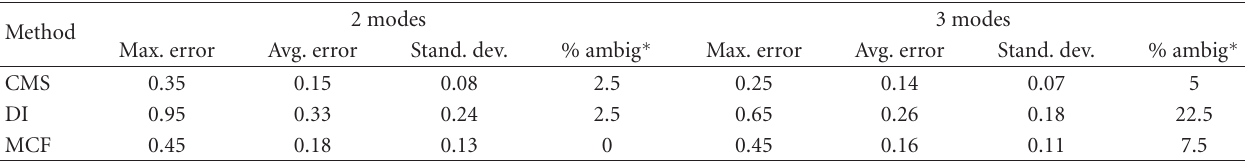
Table 4: Error in predicted damage location by each method, listed as a fraction of measurement point spacing, when two and three modes were used in combination with 7 measurement